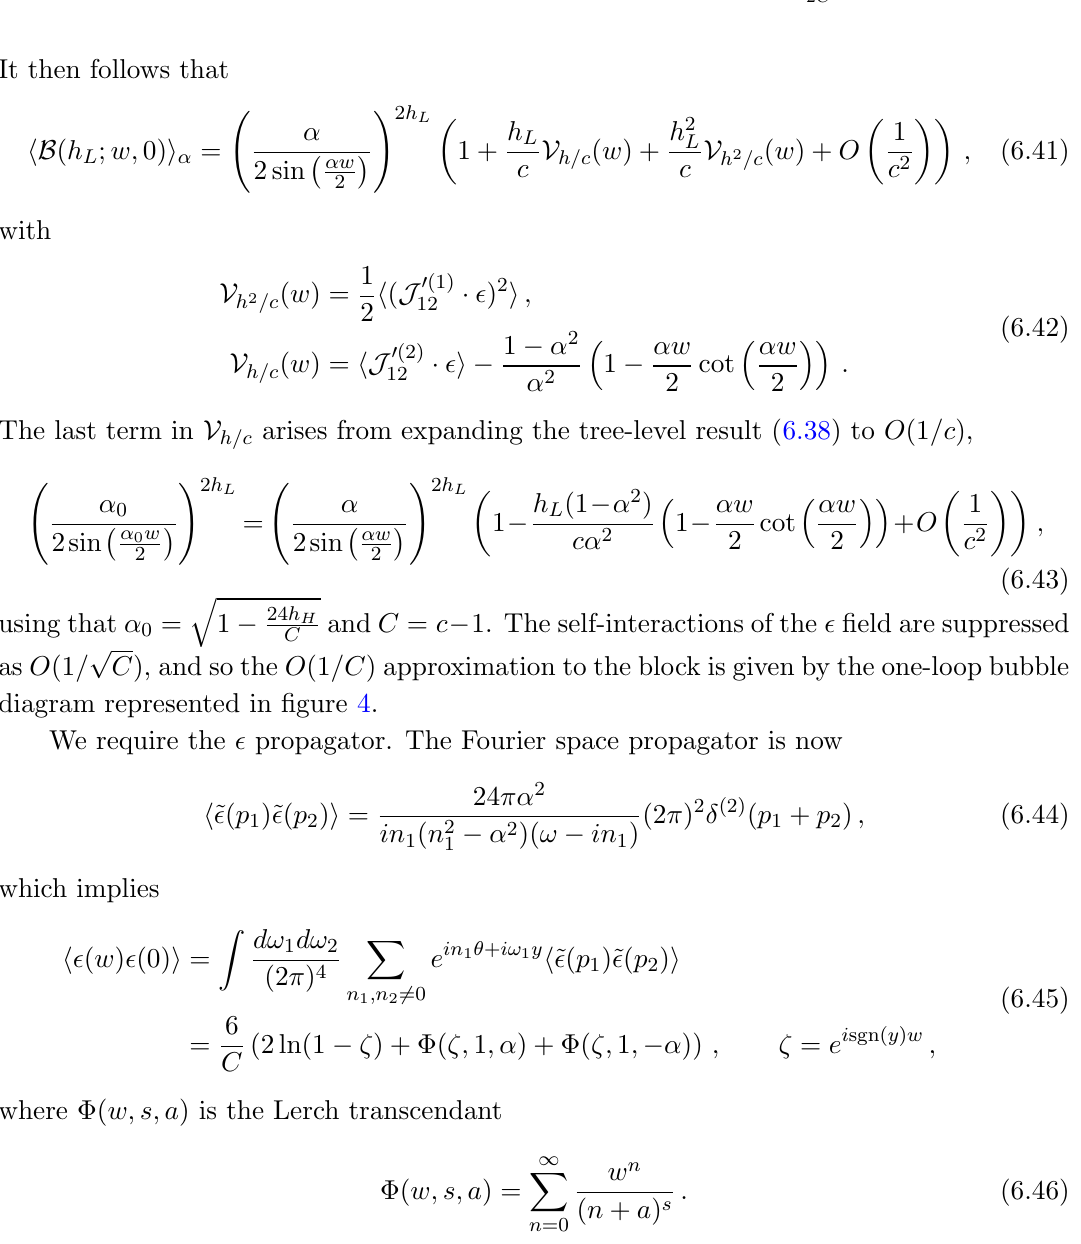
2 ( J 0 1 (cid:1) (cid:15) ) 2 + h L J 0 (2) (cid:1) (cid:15) . L 12 12 2 C